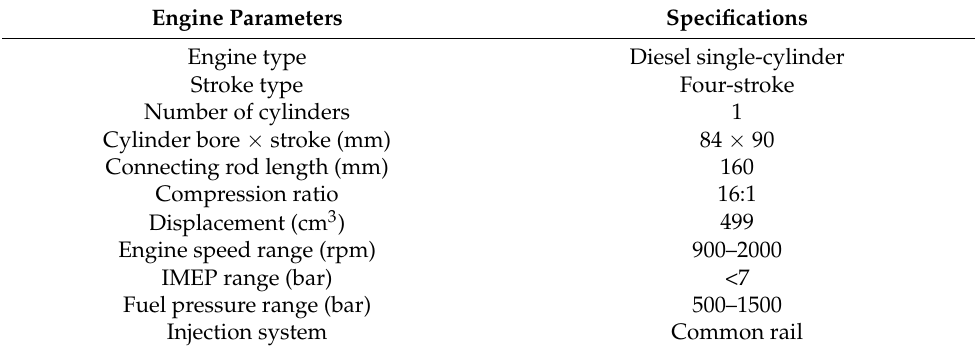
Table 1. Test engine